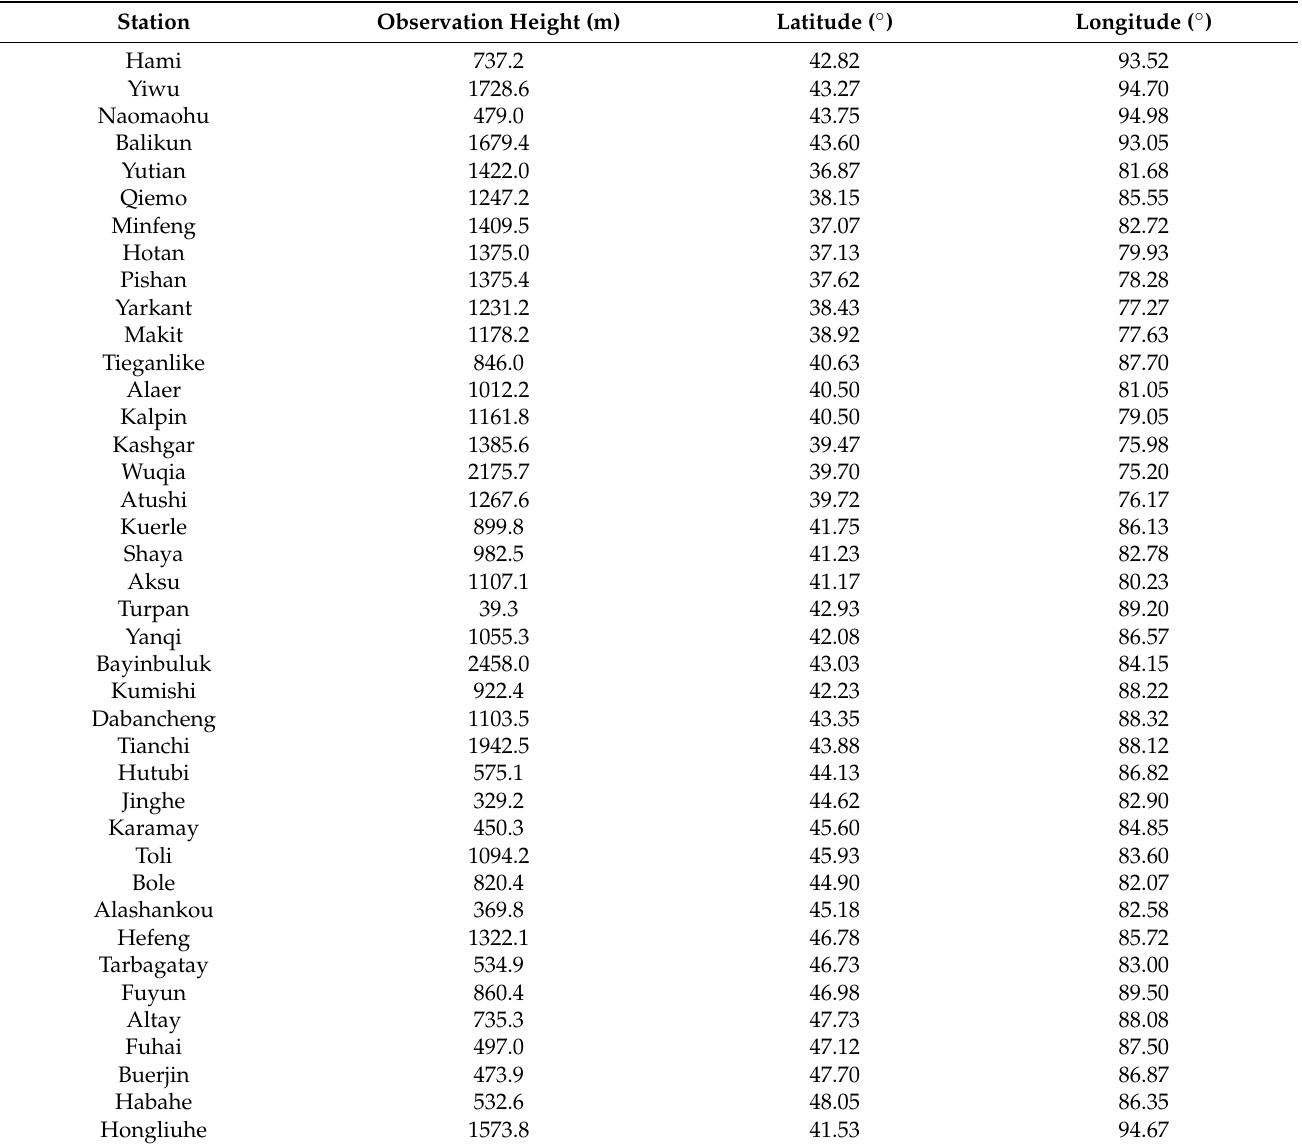
Table 1. Basic information of meteorological stations in the study